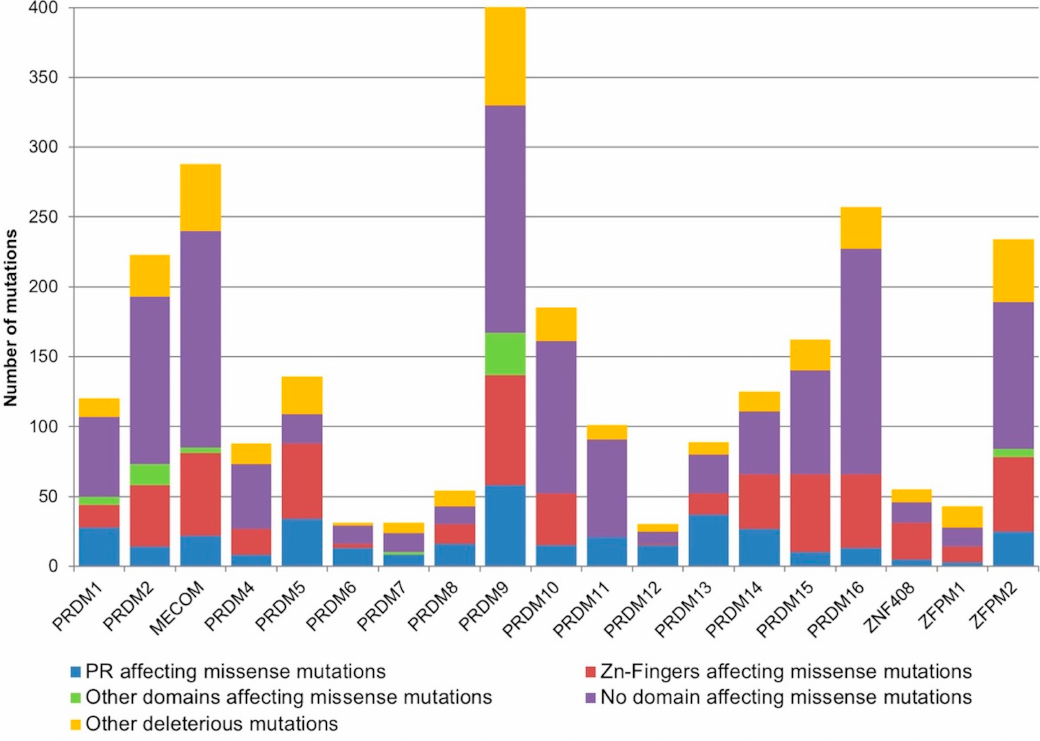
Figure 2. The stacked histogram represents the amount of deleterious somatic mutations affecting the different known domains of PRDM proteins. In detail, the missense mutations affecting the PR domain are reported in blue, the missense mutations affecting the Zn fingers are in red, and the missense mutations affecting other known domains (where present) are illustrated in green. The deleterious missense mutations not affecting known domains are shown in violet and the other classes of deleterious mutations (frameshift, in-frame deletions, stop gained and start lost mutations, splice site, UTR, and intron variants) are in orange.